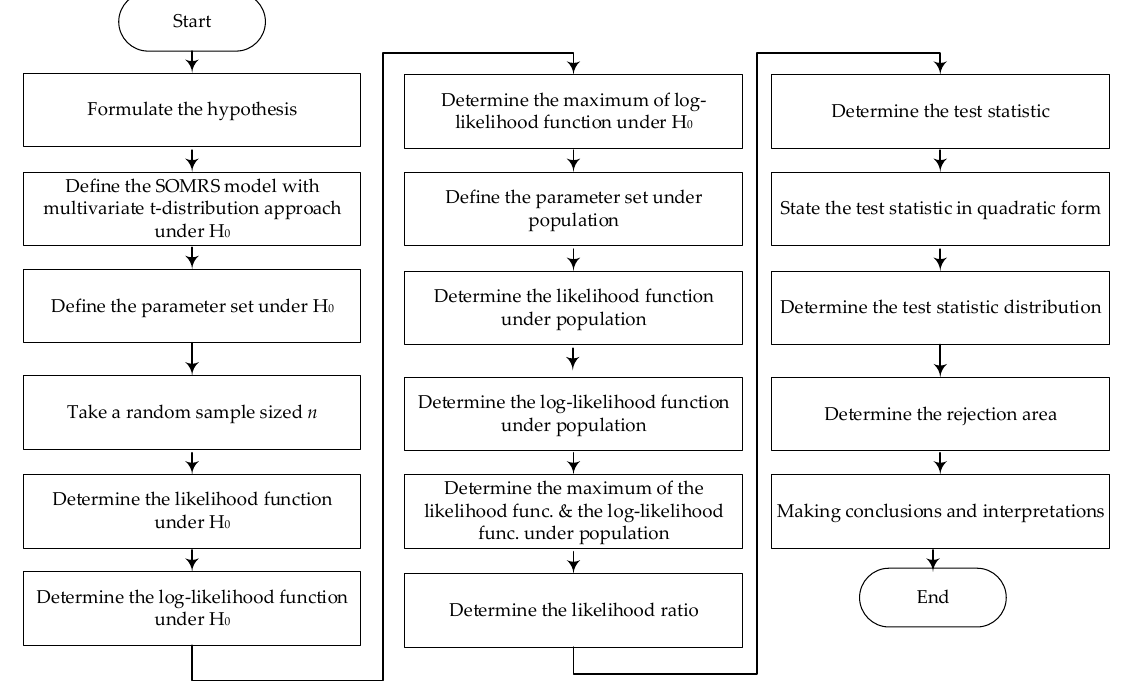
Figure 2. Model Parameter Test Flowchart.